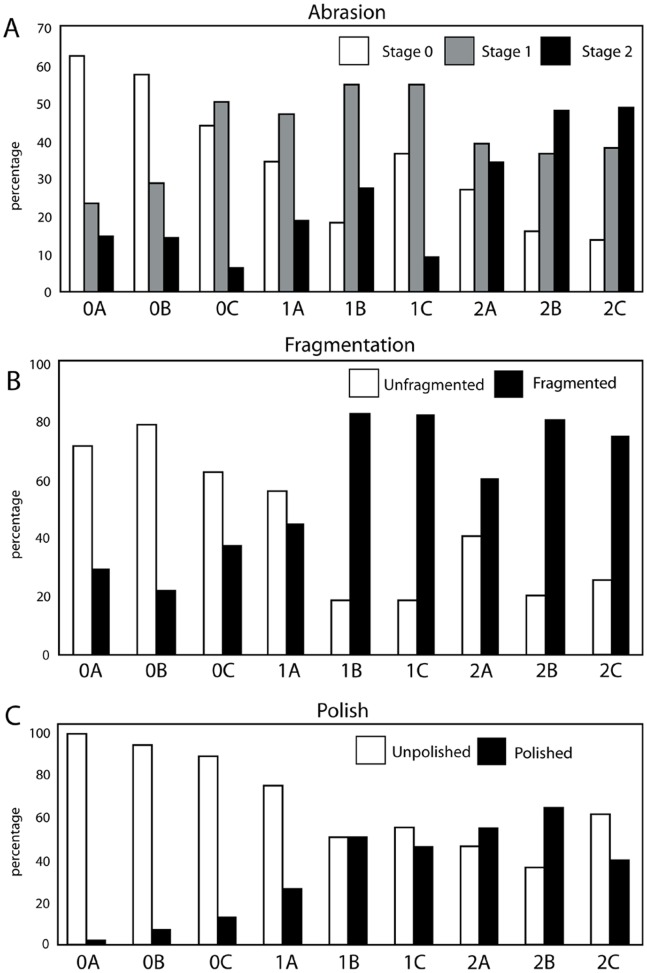
Histograms showing relationship between phosphatization stage and other bone modifications.Bone modifications include (A) abrasion, (B) fragmentation, and (C) polish; values displayed as percentage of elements showing each phosphatization stage and bone modification.